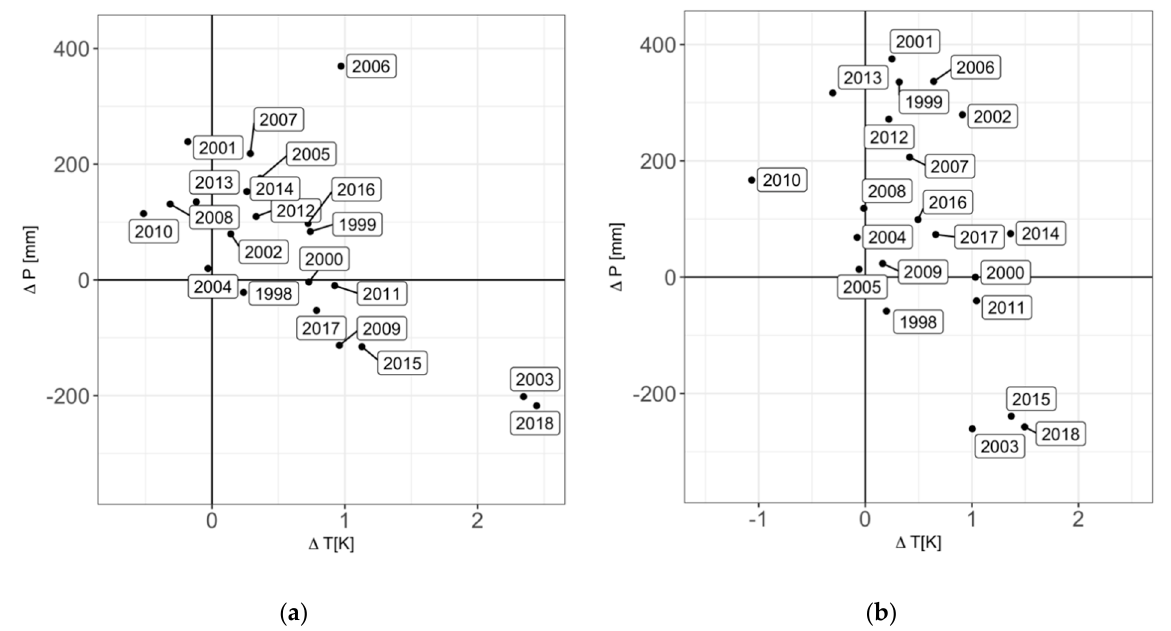
Figure 2. Thermopluviograms depicting annual anomalies of mean annual air temperature (K) and mean annual precipitation sum (mm) from the 50-year observation period for the research area (data source: German NFI environmental data base [53]). Horizontal baseline stands for mean annual air temperature, vertical baseline for mean annual precipitation